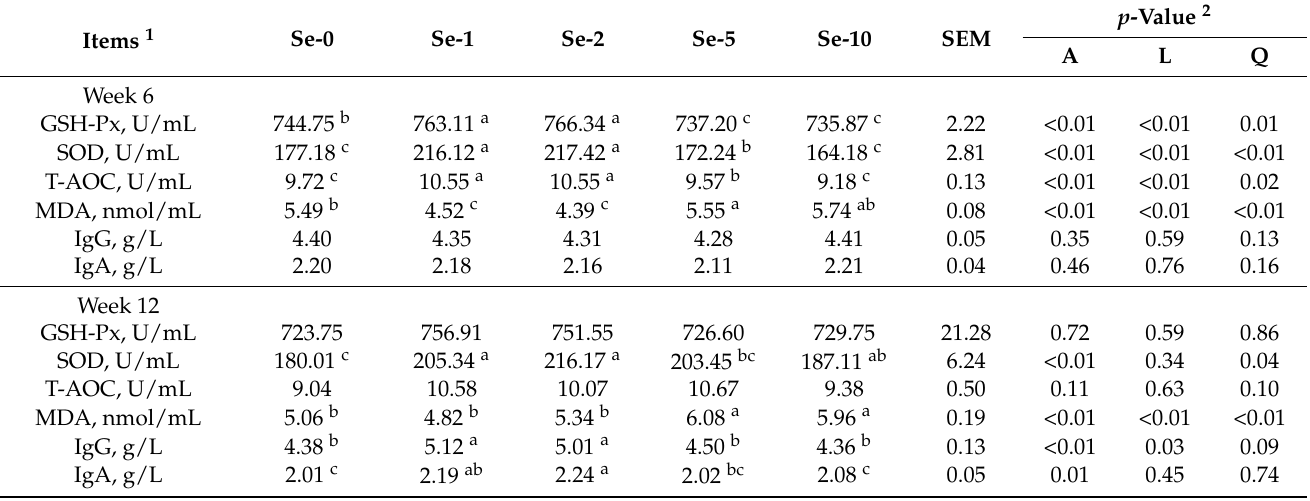
Table 7. Effects of dietary organic selenium on the serum antioxidant and immune capacity of laying